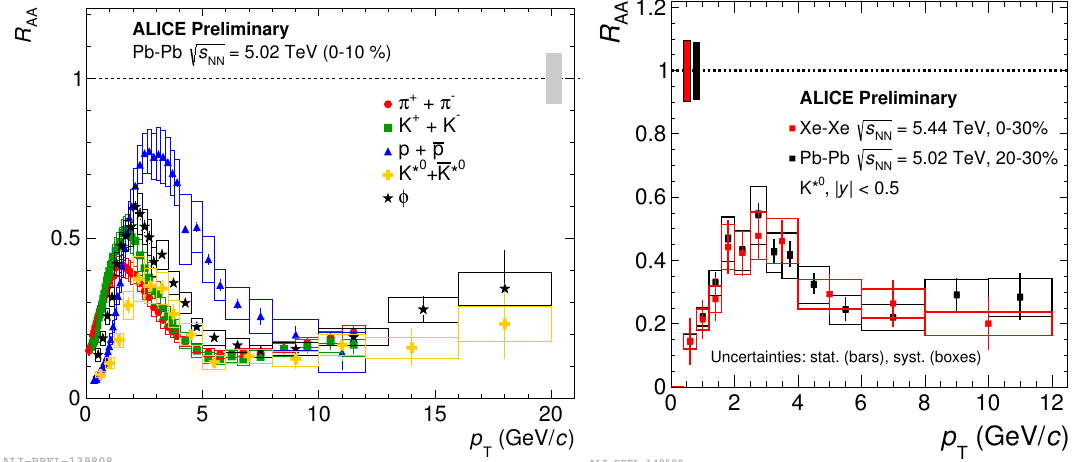
Figure 3. (Color online) Left panel: R AA as a function of p T of π , K , p , K ∗ 0 and φ for centrality class 0–10 % √ s NN = 5.02 TeV. Right panel: R AA as a function of p T of K ∗ 0 in Xe–Xe collisions at in Pb–Pb collisions at √ √ s NN = 5.44 TeV and Pb-Pb collisions at s NN = 5.02 TeV for centrality classes with similar charged particle multiplicity. The bars and the boxes represent the statistical and systematic uncertainties